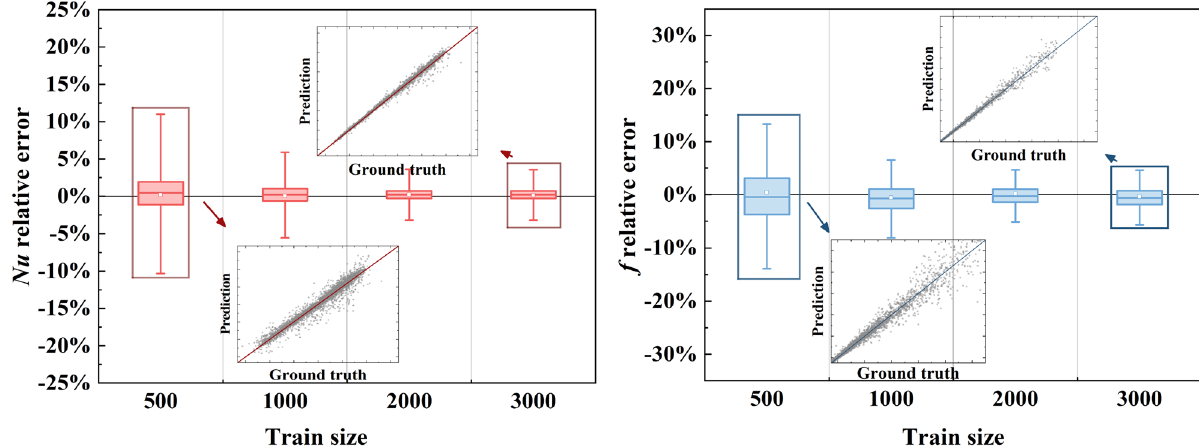
Figure 11. Relative errors of performance vs. Train